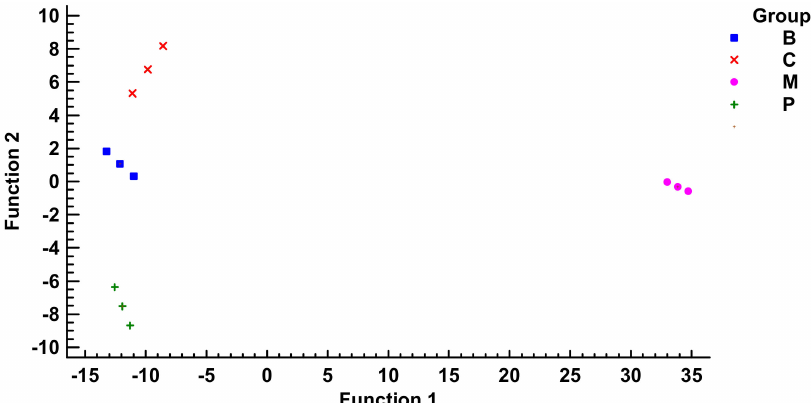
Figure 5. Discriminant biplot for the classification variables of IC 50 values (BuChE, 5-LOX, h MAO-A and h MAO-B). Note that linear discriminant function 1 accounts for the 93% of variance and clearly separates (cid:48) Mansa (cid:48) (M) EVOO from the rest, mainly because of the weight of BuChE but also h MAO-A, whereas the discriminant function 2 with a 6% of the variance allows the discrimination between (cid:48) Cornicabra (cid:48) (C), (cid:48) Brava (cid:48) (B) and (cid:48) Picual (cid:48) (P) EVOOs with the weights of h MAO-B and